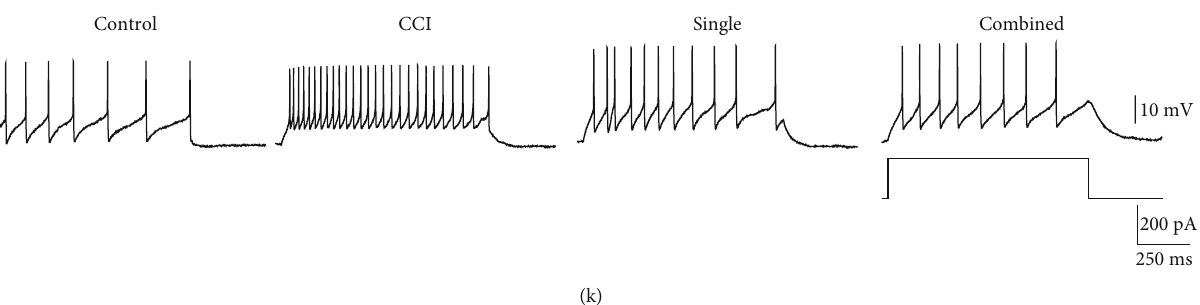
Figure 2: Combined-acupoint EA inhibit the synaptic transmission at the spinal level to a greater extent than Single-acupoint EA in mice. (a) Schematic (top) and timeline (bottom) of the CCI model, pain behavior tests (von Frey), and EA stimulation in control, CCI, combined, and single groups of vGlut2-tdTomato mice. (b) Schematic showing how to mate vGlut2-Cre and Ai9-LSL-tdTomato reporter mice to generate vGlut2-tdTomato mice to speci fi c labeling of vGlut2-positive neurons in spinal dorsal horn. (c) Schematic showing the strategy for electrophysiological whole-cell recording of vGlut2-tdTomato-positive neurons in the lamina I and IIo of sagittal spinal slice attached dorsal root. Representative response of C- fi ber evoked EPSP at 1.2V stimulation of dorsal root in the control group (d) and in the CCI group at 10 days after CCI (e). Representative response of C- fi ber evoked EPSP at 1.2V stimulation of dorsal root in the combined group (f) and single group (g) at 10 days after CCI followed by 6 consecutive days and 1-day o ff EA treatment. (h) Amplitude of eEPSP recorded in the control, CCI, combined, and single groups. One-way ANOVA and Bonferroni ’ s post hoc analysis. (i) Rheobase of vGlut2-tdTomato neurons in the control, CCI, combined, and single groups. One-way ANOVA and Bonferroni ’ s post hoc analysis. (j) Number of spikes in response to 1000 ms depolarizing current injection of varying amplitude. Two-way repeated measures analysis of variance (ANOVA) followed by Bonferroni ’ s post hoc analysis. (k) Representative tonic fi ring pattern in response to 1000ms depolarizing 200pA current injection. All data are mean ± SEM , ∗ P < 0 : 05 , ∗∗ P < 0 : 01 , ∗∗∗ P < 0 : 001 vs. CCI; ## P < 0 : 01 , ### P < 0 : 001 vs. single, N = 6 in each group. RMP: resting membrane potential; CCI: chronic constriction injury; combined: ST36+GB30; single: ST36; PWMT: paw withdrawal mechanical threshold; vs: versus; orange column indicated the EA; gray column indicates the von Frey (combined vs. CCI, P < 0 : 001 , Figures 2(e) – 2(g)). Mean-